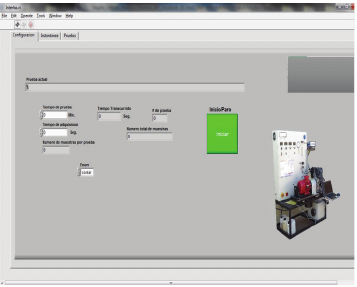
Figure 17: Main window graphical user interface, tab settings.